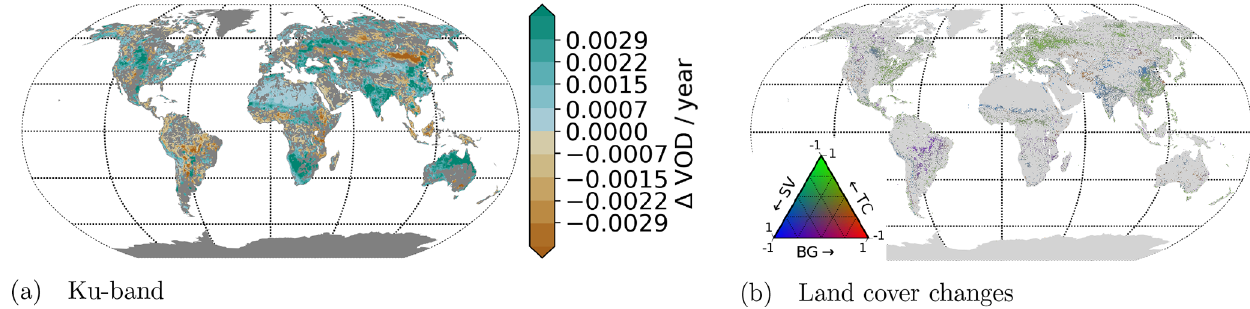
Figure 15. Trends between 1987 and 2016 of Ku-band VOD (a) and VCF tree canopy, short vegetation, and bare ground (b) . Non-significant trends are not displayed, and the trends are calculated by the Theil–Sen estimator using yearly mean